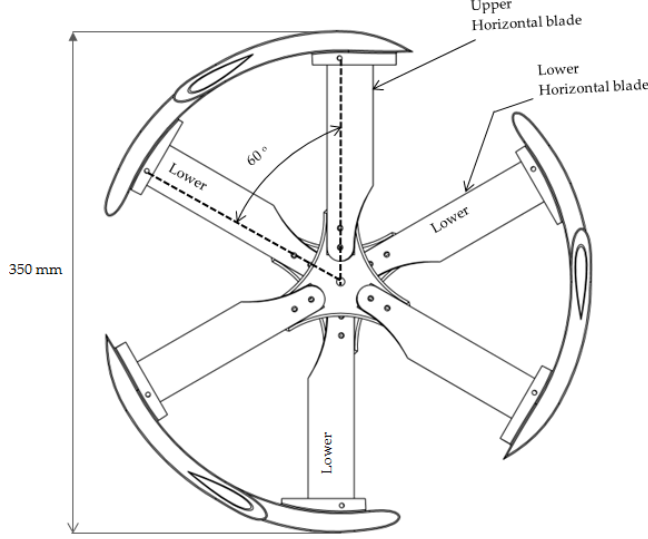
Figure 5. Top view of the CAWT showing the 60° offset angle of the upper and lower horizontal blades.